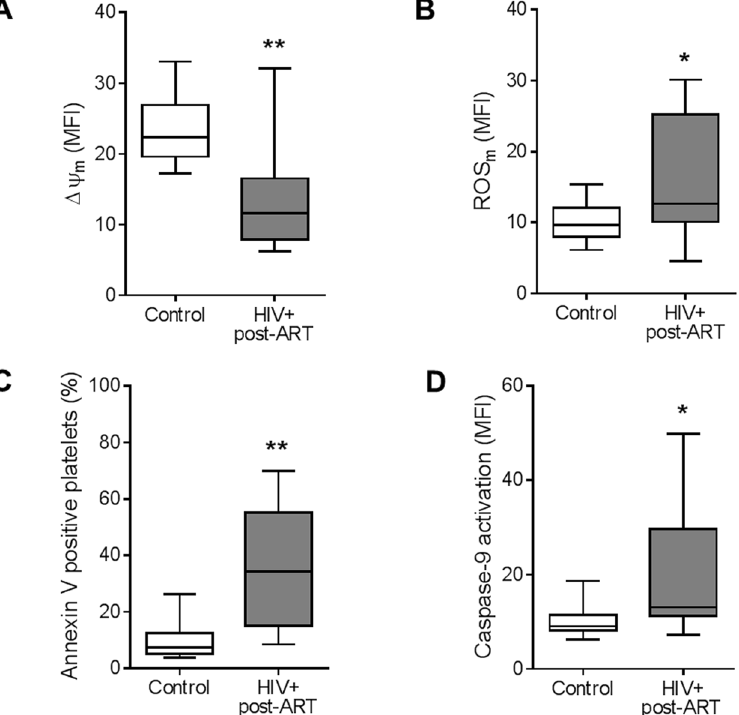
Figure 2. Mitochondrial dysfunction and apoptosis in platelets from HIV-infected individuals under stable cART. ( A ) The mean fluorescence intensity (MFI) for TMRE indicating the mitochondrial membrane potential ( ∆ ψ m ), ( B ) the MFI for MitoSoxRed indicating mitochondrial generation of reactive oxygen species (ROS m ), ( C ) the percentage of platelets that bind annexin V, and ( D ) the MFI for the probe FLICA indicating caspase-9 activation were assessed in platelets freshly-isolated from healthy volunteers (control) or from HIV-infected individuals under viral control (HIV-1 viral load < 50 copies/ml in the peripheral blood). Box plots: The horizontal lines on the box plots represent the median, boxes limits indicate interquartile ranges and the whiskers indicate 5–95 percentile. The asterisk ( * ) signify p < 0.05 compared to healthy